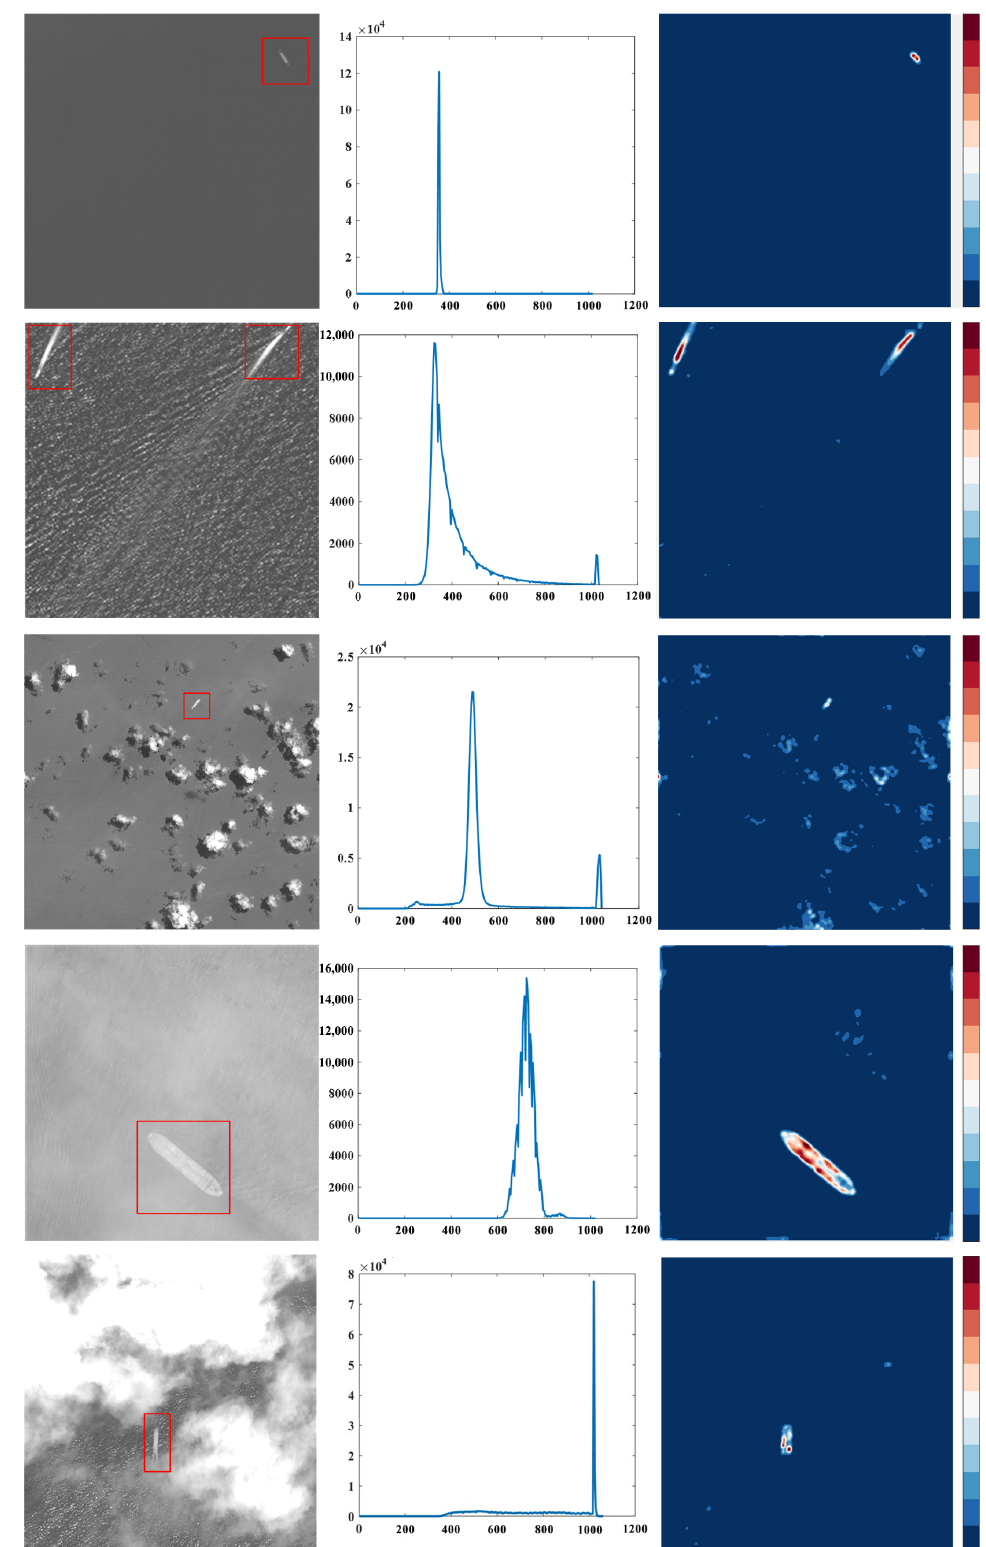
Figure 1. Marine scenes under different types of interference, namely, cloudless areas (with no waves and big waves), scattered clouds areas, thin cloud areas, and thick cloud areas. The images in the first column are the original panchromatic images from the GF-1 dataset. Ship targets are displayed in red boxes. The histograms of the grayscale statistics are illustrated in the second column. The last column contains images that show the heat maps representing the visual saliency of each